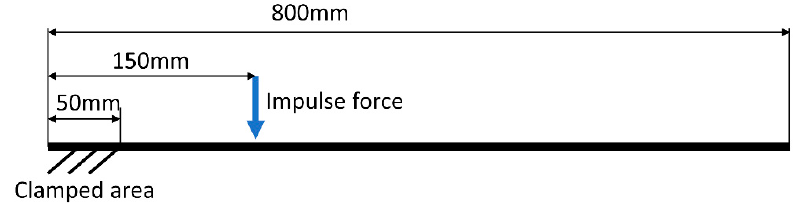
Figure 7. Scheme boundary conditions applied in dynamic simulation.